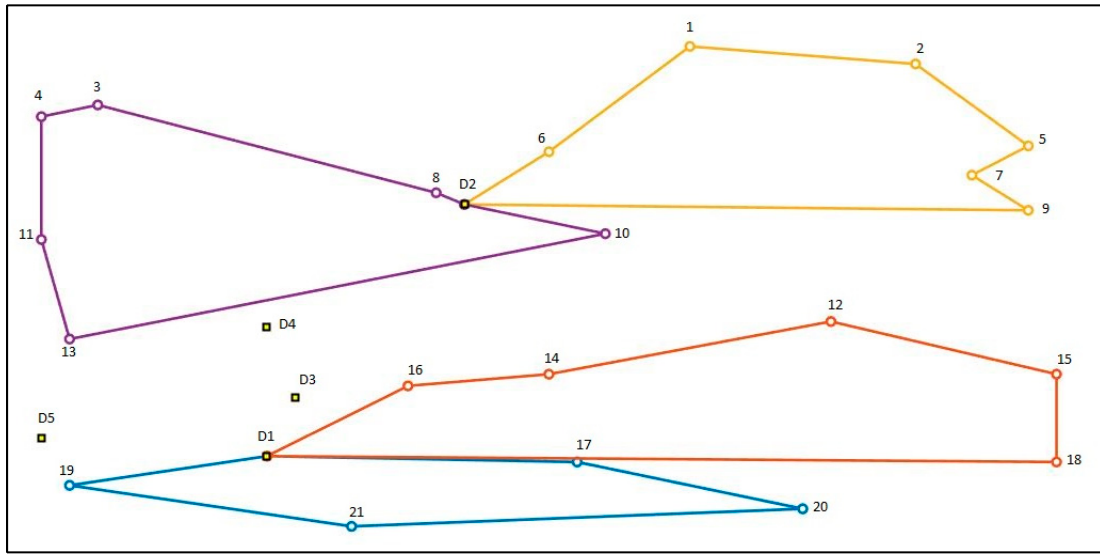
Figure 7. Topological layout of the Gaskell 1 produced by HS-SA for LIRP.